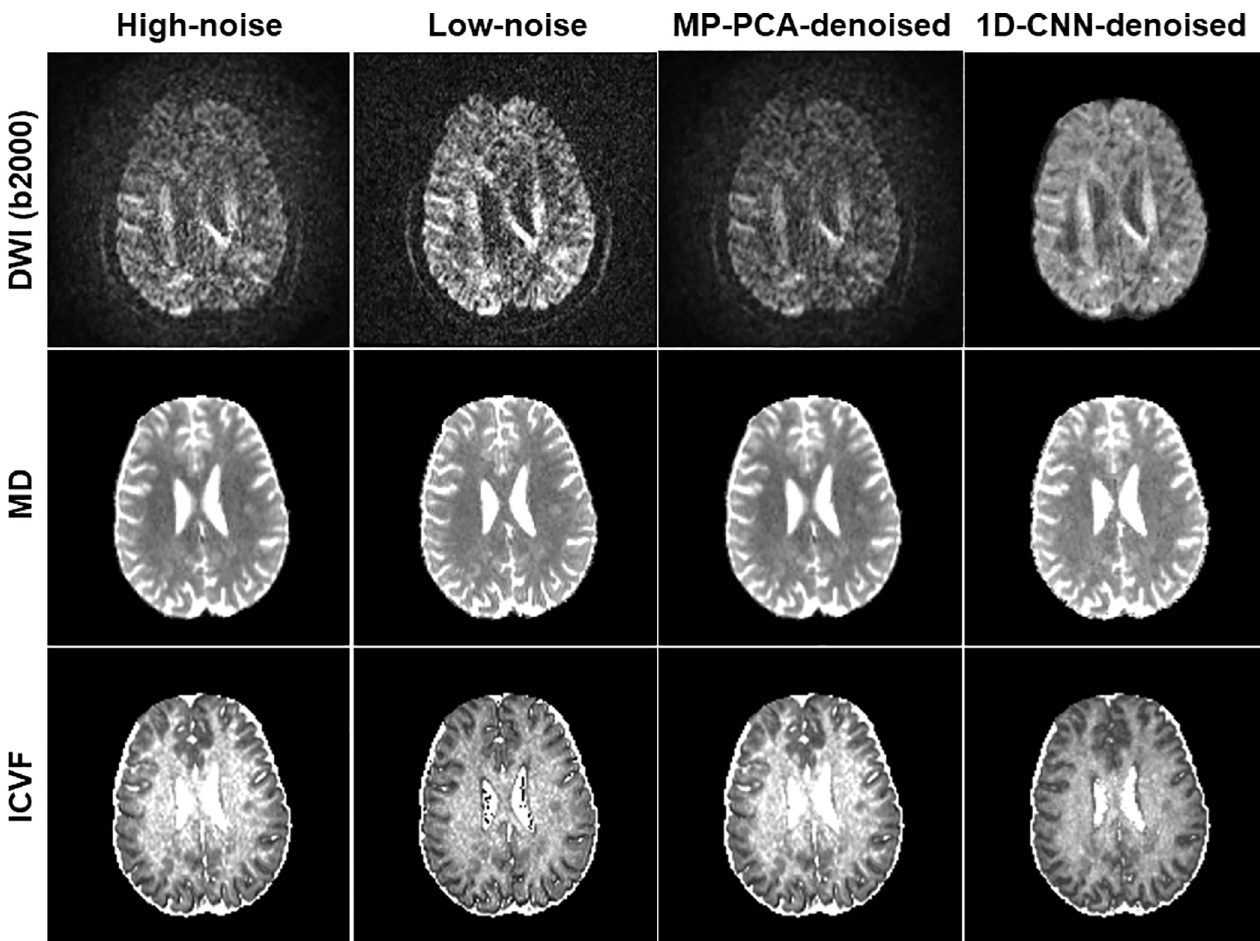
Fig 9. The original high-noise image, low-noise image, and denoised images using MP-PCA and 1D-CNN along with derived MD and ICVF maps of a representative slice in Experiment 2 (SMS4 vs. SMS1) for b-value 2500 s/mm 2 .